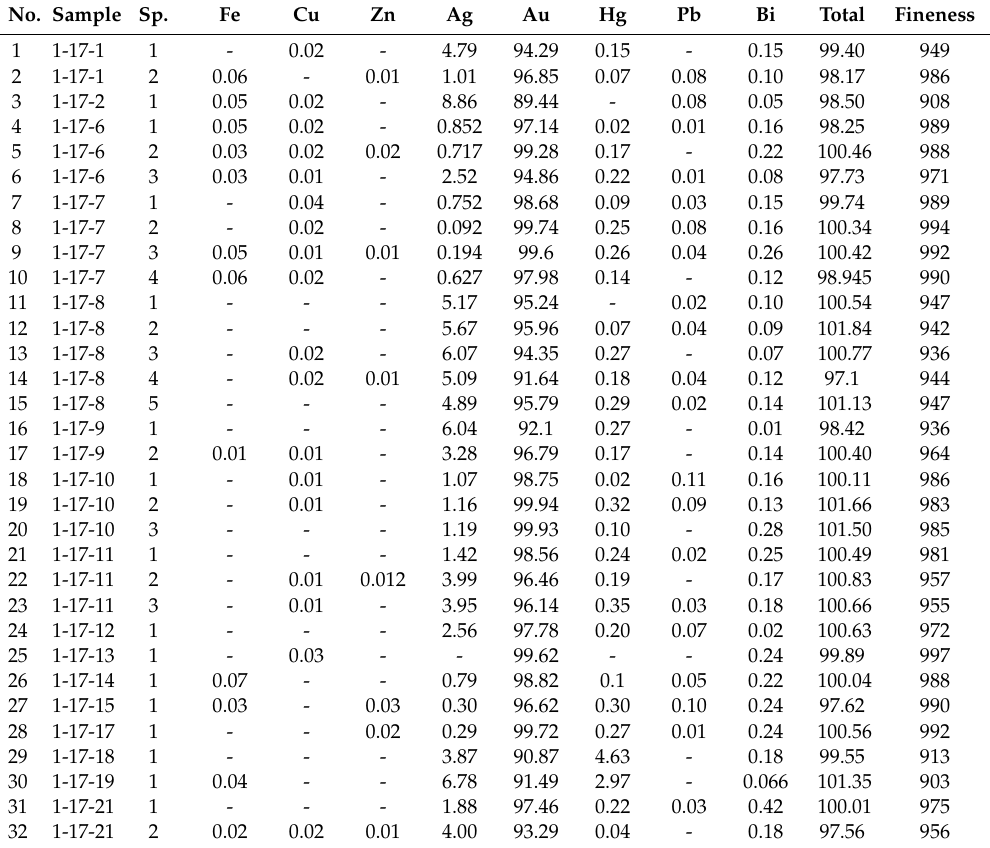
Table 5. The composition (in wt%) and fineness (in % (cid:24) ) of the porous gold shown in Figure 11. No. Sample